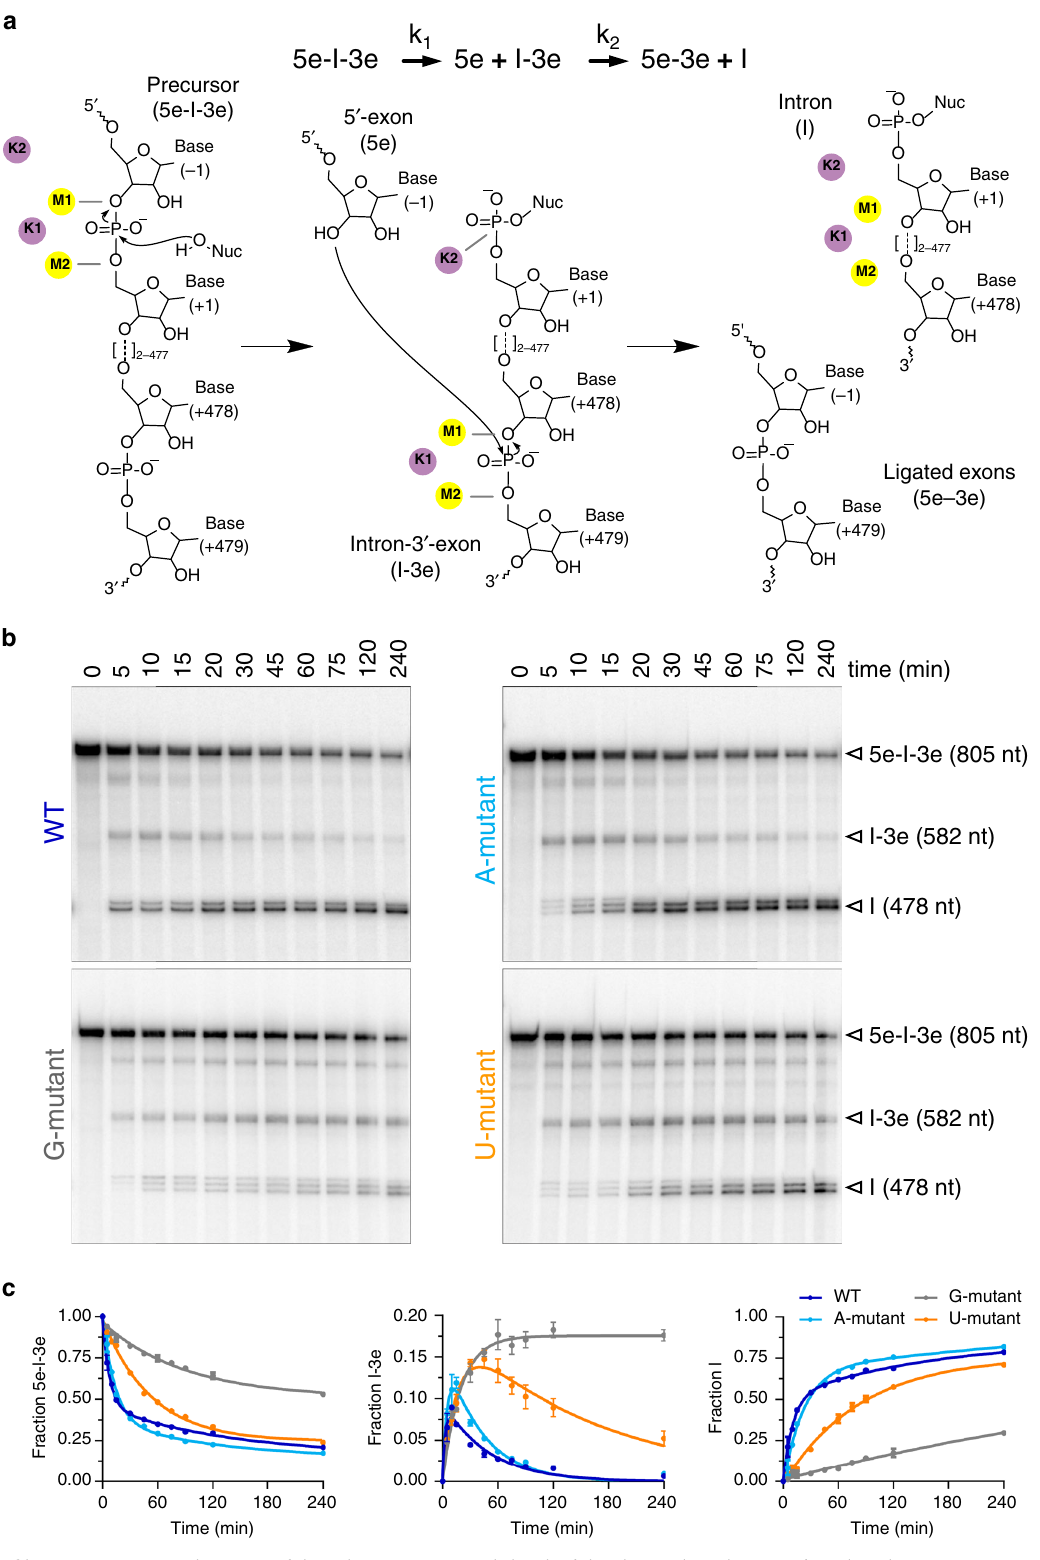
Fig. 1 Kinetics of intron mutants. a Schematics of the splicing reaction and sketch of the chemical mechanism of catalysis by group II introns. k 1 is the rate constant of the fi rst and k 2 of the second step of splicing. Kinetic rate constants of all constructs are reported in Supplementary Table 2. Black arrows indicate nucleophilic attacks; gray dotted lines indicate interactions between oxygen atoms of the scissile phosphate groups and catalytic metal ions; Nuc indicates the reaction nucleophile. b Representative splicing kinetics of wild-type intron and A, G, and U mutants. Precursors are indicated as 5e-I-3e (nt length in parenthesis). Intermediate (I-3e) and linear intron (I) migrate as double or triple bands because of cryptic cleavage sites, as explained previously 16 . c Evolution of the populations of precursor (5e-I-3e, left panel), intermediate (I-3e, middle panel), and linear intron (I, right panel) over time. Error bars represent standard errors of the mean (s.e.m.) calculated from n = 3 independent experiments. Source data are provided as a Source Data fi